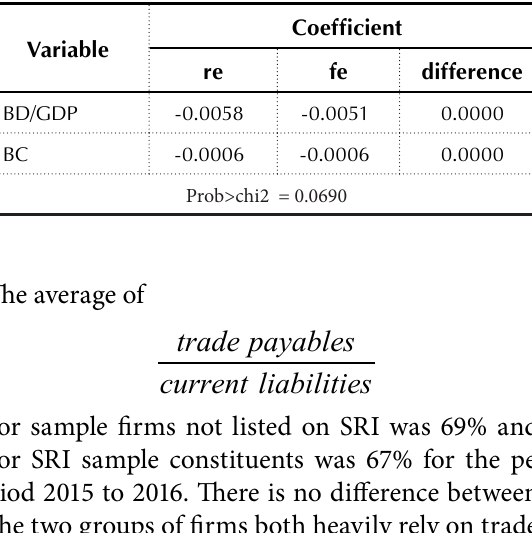
Table 1. Hausman test